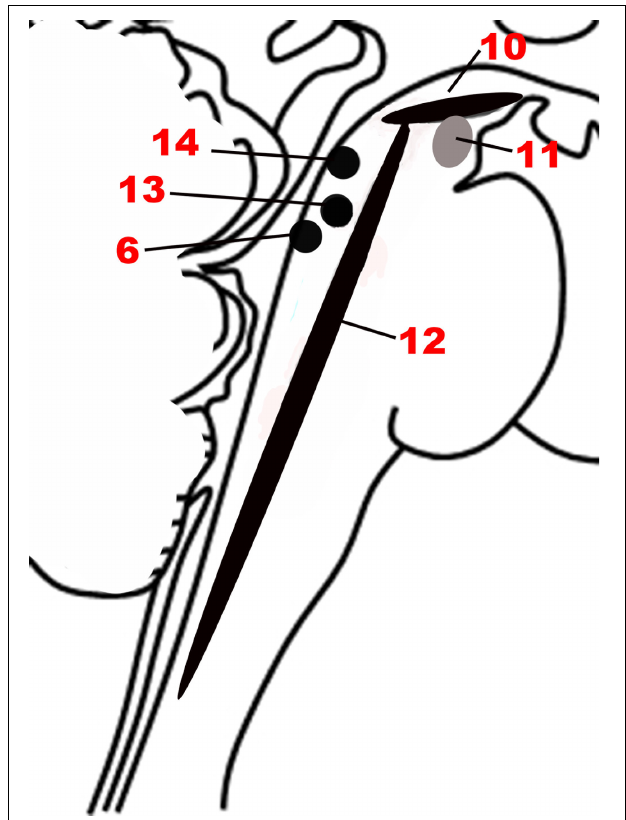
FIGURE 5 | The nuclei of the Modulatory network. (10) Substantia nigra. (11) Ventral tegmental area. (12) Raphe nuclei. (6) Locus coeruleus. (13) Pedunculopontine nucleus. (14) Laterodorsal tegmental